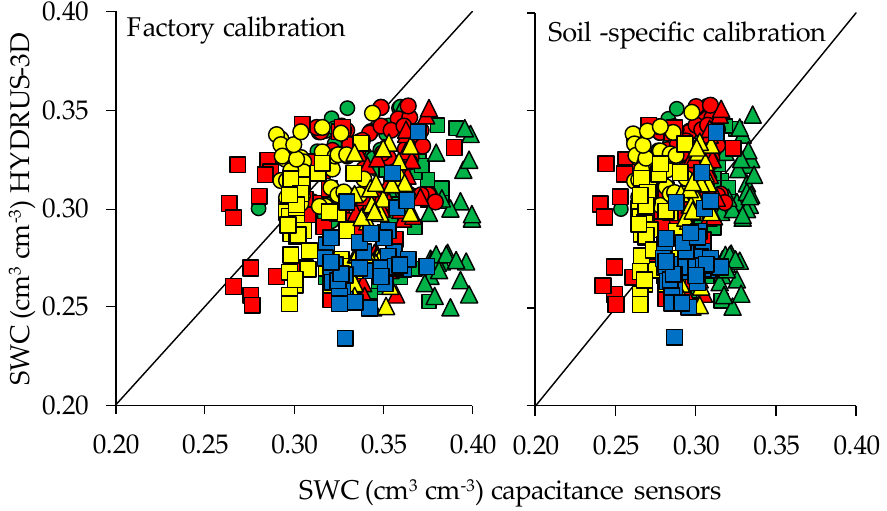
Figure 13. Fit between soil water content (SWC) measured by capacitance sensors and estimates by HYDRUS-3D, comparing factory calibration of the sensors with soil-specific calibration. Data includes one measurement every 15 days during the whole studied period. Colors indicate sensor position relative to dripper (green = A, red = B, yellow = C, blue = D) and shapes indicate depths ( ◯ = 15 cm, □ = 30 cm, ∆ = 60 cm).